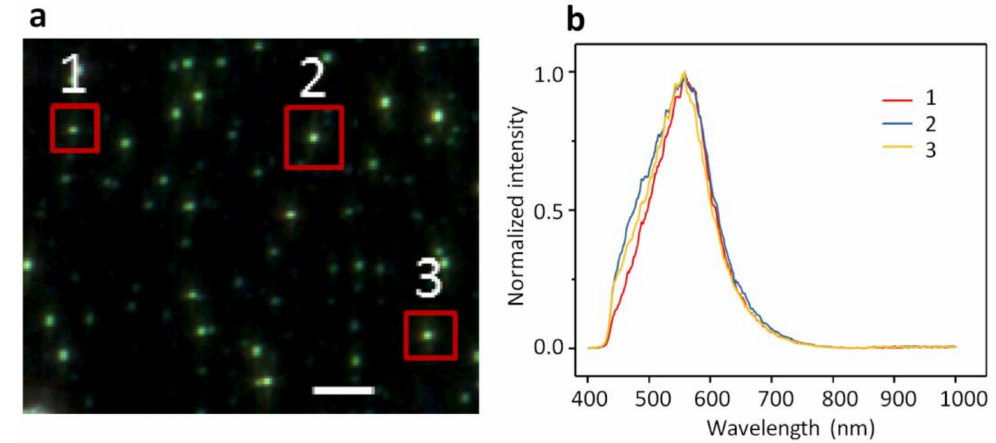
Figure 2. ( a ) A DFM image of 10-nm AgNPs dispersed in PBS buffer and ( b ) the normalized spectral profiles collected from three different particles specified in ( a ). The three spectral profiles in ( b ) peak are around 550 nm. Scale bar is 5 µ